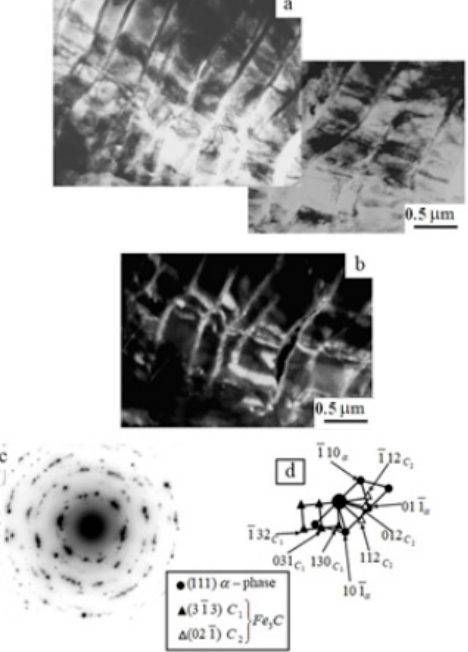
Figure 5. Image of unfragmented lamellar pearlite in the zone of localized deformation of the initial sample of 0.2 C steel. Transmission electron microscopy: ( a )—bright-field image; ( b )—dark-field image obtained in closely located [ 011 ] α -phase and cementite [ 012 ] reflexes; ( c )—microdiffraction pattern and ( d )—its indexed scheme.